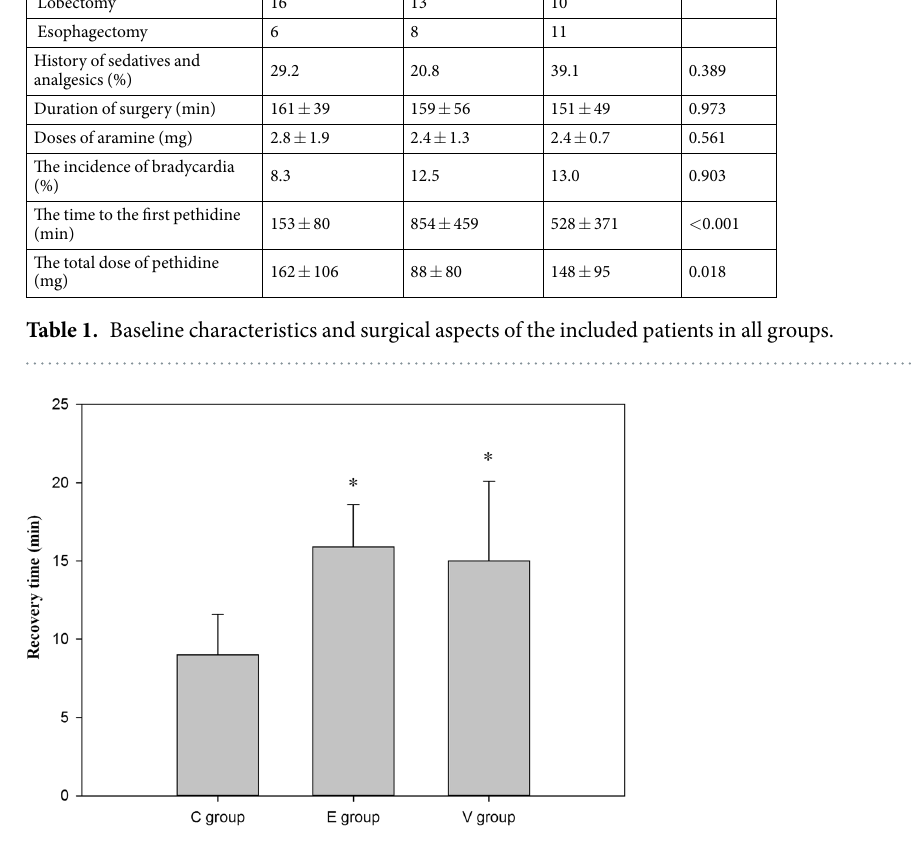
Figure 2. Propofol doses for the recovery time after cessation of propofol infusion to the BIS level of 80 (mean and SD). * : compared with Group C, p <